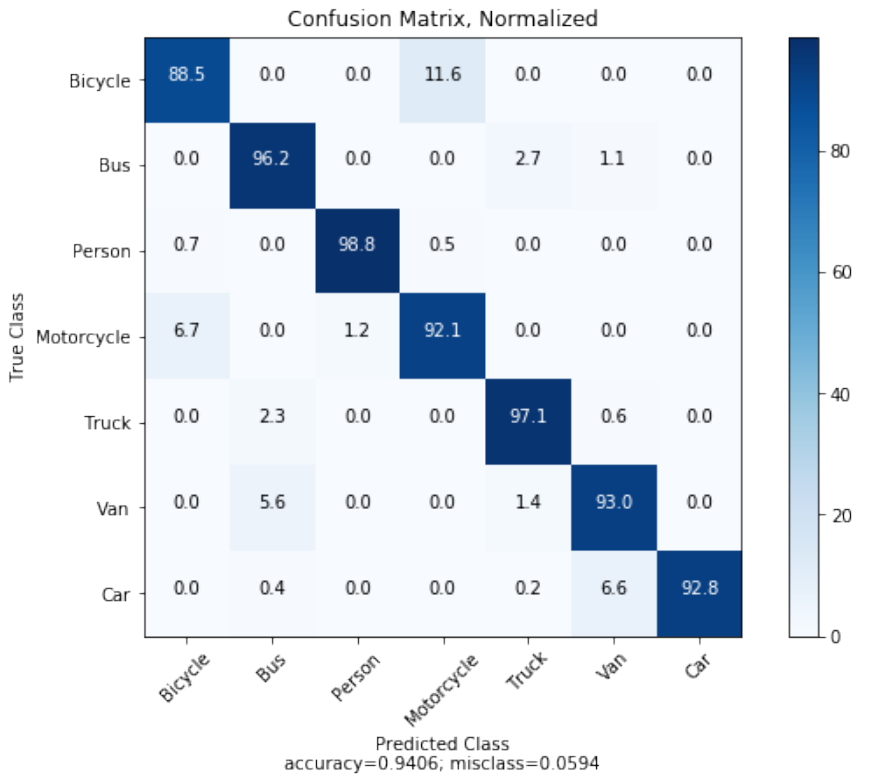
Figure 12. Normalized confusion matrix for the object classifications. Table 3. Gradual precision and recall values of various classes. Class Precision